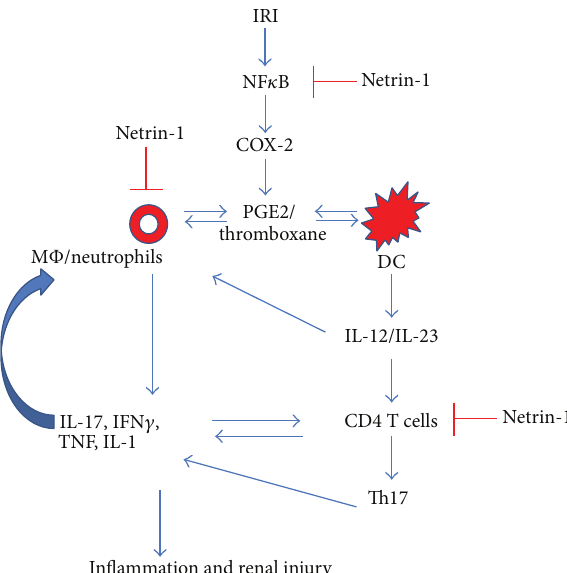
Figure 5: Pathways of inflammatory mediators and their regulation of netrin-1 during ischemia reperfusion injury of the kidney. Ischemic insults initiate inflammation in the kidney through acti- vation of NF 𝜅 B mediated COX-2 expression and prostaglandin E2/thromboxane production. These mediators, acting through an autocrine or paracrine mechanism, stimulate the production of cytokine and chemokines from monocyte (M Φ ), neutrophils, and dendritic cells (DC). T cells may be activated through DC or direct activation by soluble mediators released from other cells or receptor mediated mechanism. Activation and release of soluble mediators from these white blood cells cause vascular leakage, edema, hypoxia, and tubular epithelial cell damage which will be manifested as kidney dysfunction. Netrin-1 reduces the severity of these events by acting at multiple levels through downregulation of COX-2 expression and suppression of inflammatory mediators